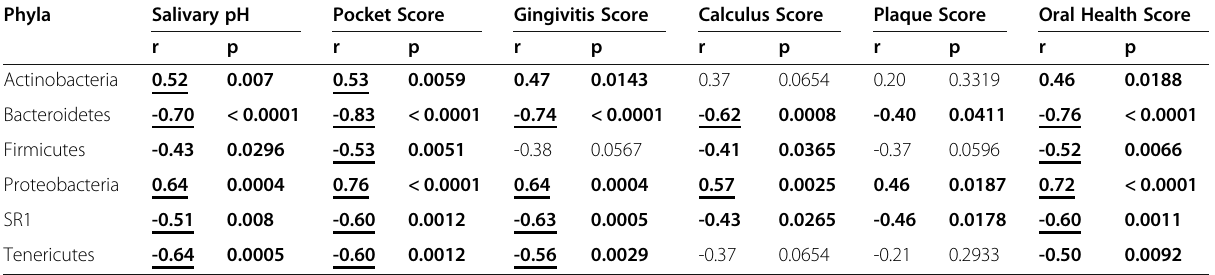
Table 5 Correlation coefficients (r) between oral health scores, plaque scores, calculus scores, gingivitis scores, pocket scores, pH, and bacterial phyla in supragingival samples ( n = 26) 1